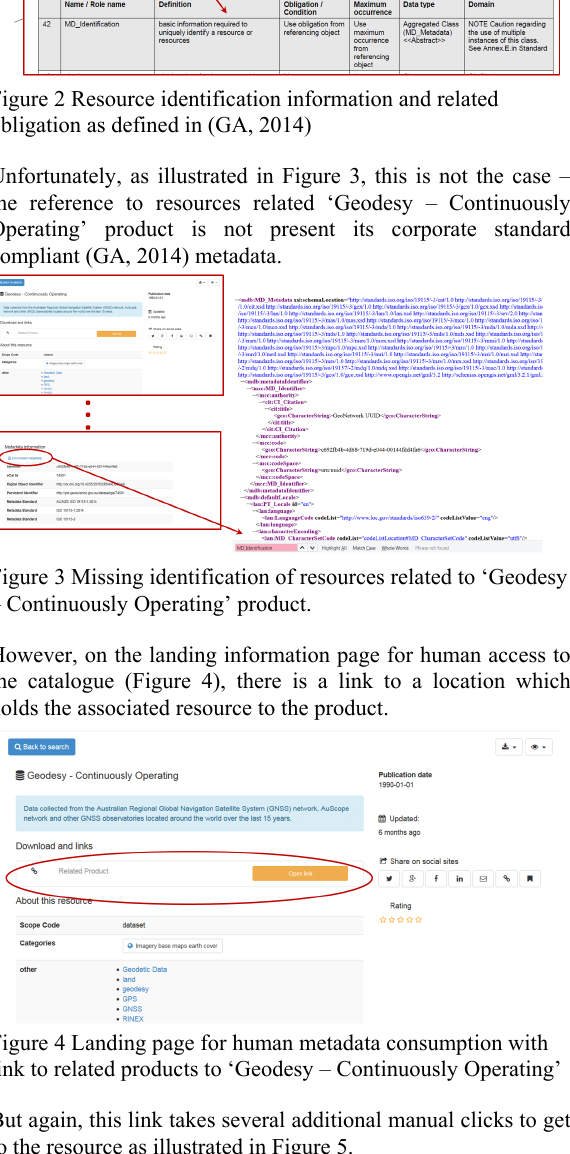
Figure 5 Navigating to the digital resource of interest